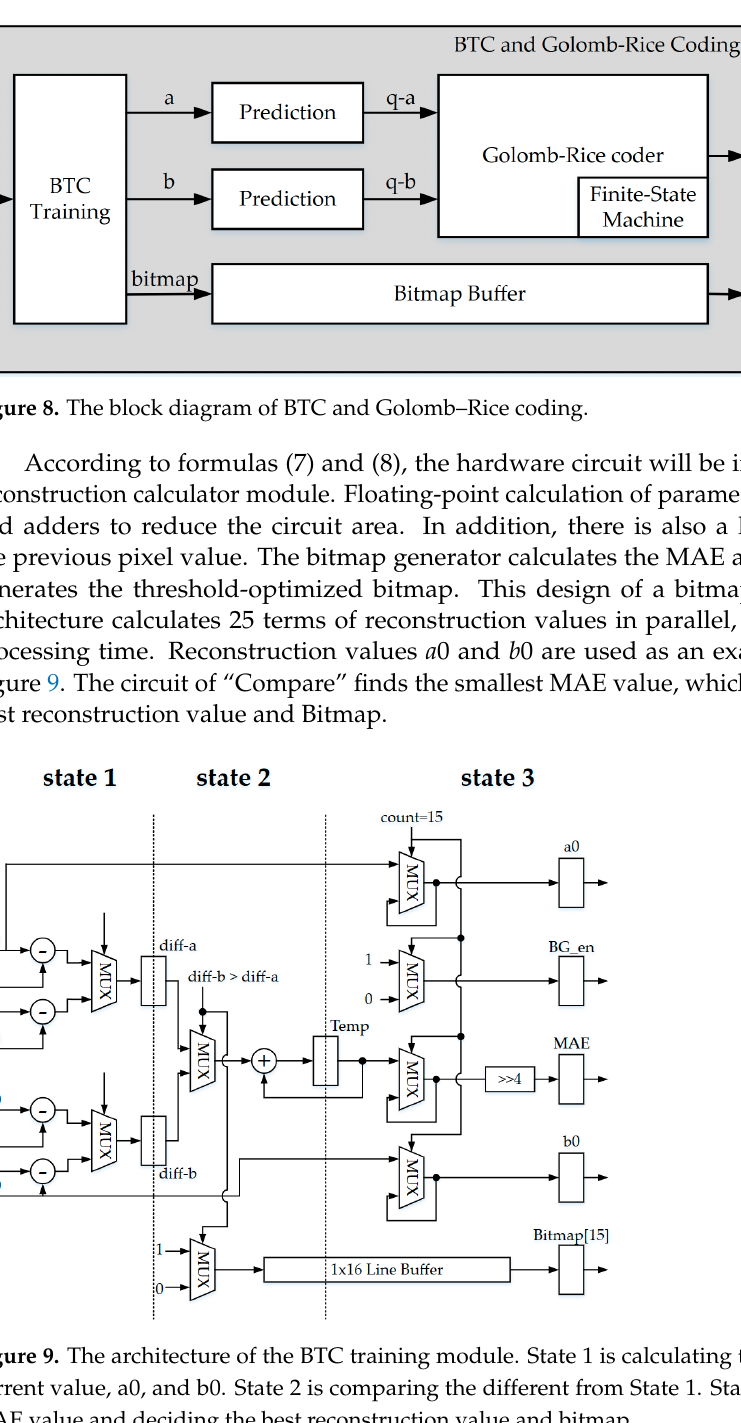
Figure 7. The modular structure of this study. ( a ) Register bank module. ( b ) Parameter calculator module.